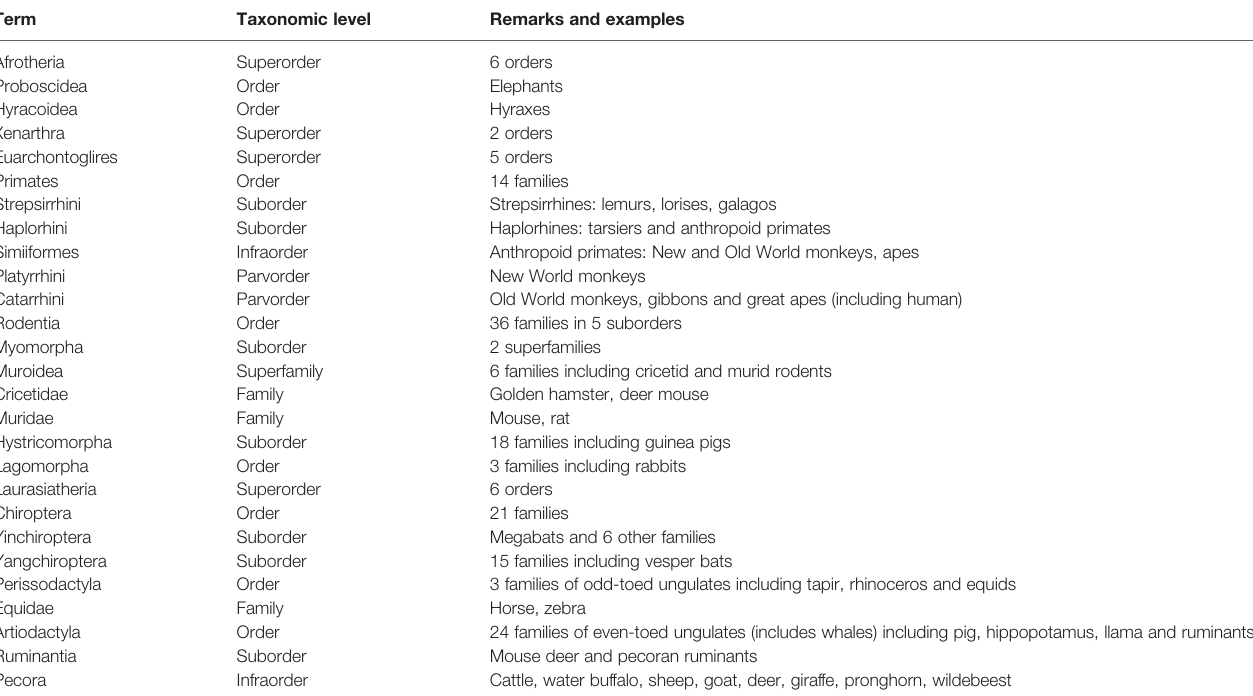
TABLE 1 | Terminology of eutherian mammals encountered in this